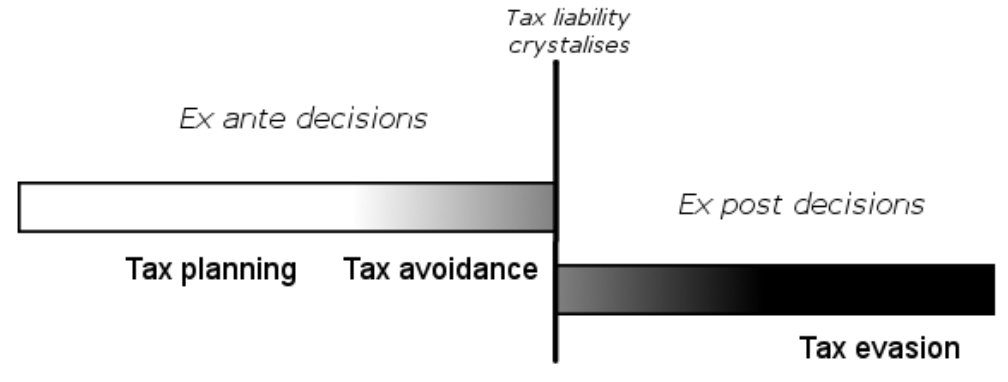
Figure 2. Tax planning, avoidance, and evasion.